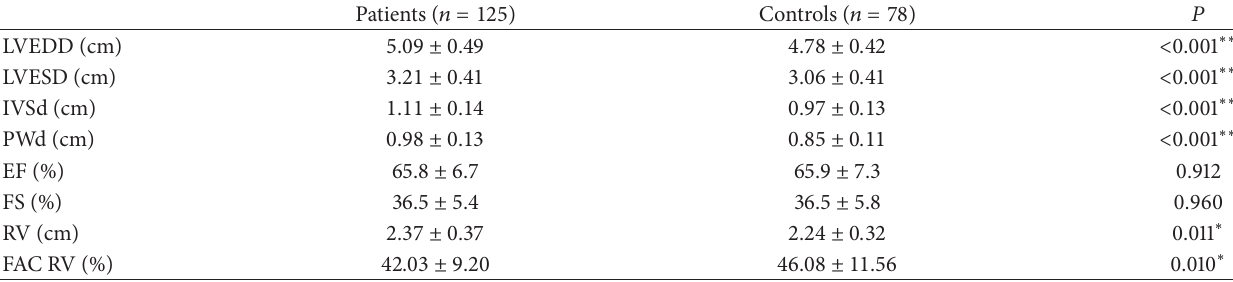
Table 3: Echocardiographic parameters of OSA patients and control subjects.